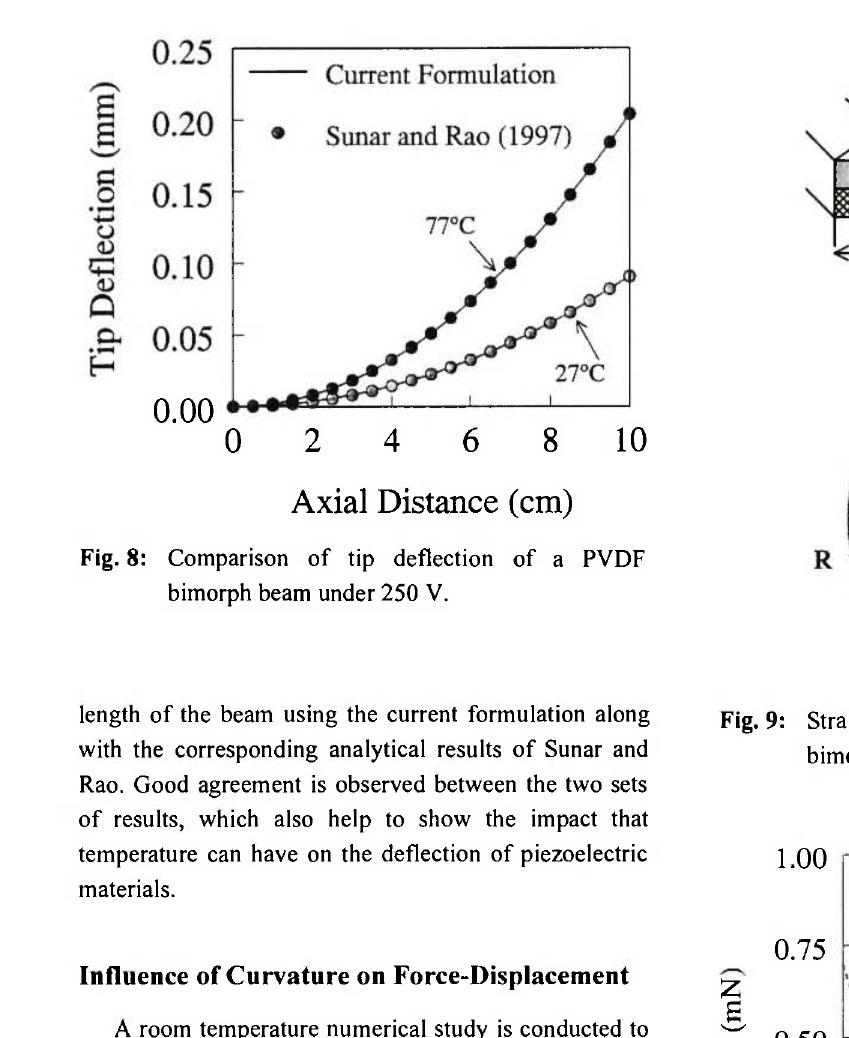
Fig. 9: Straight and equivalent curved piezoelectric bimorph beams.